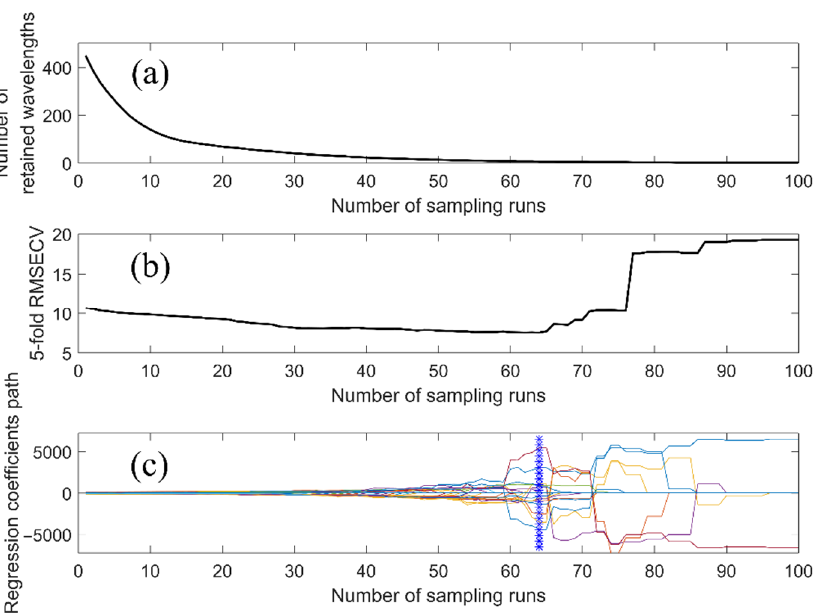
Figure 6. The process of feature wavelength selection by CARS. ( a ) The number of retained wave- lengths with the increase in sampling runs; ( b ) the 5-fold RMESCV of the PLS model established based on the retained wavelengths; ( c ) the regression coefficients of the retained wavelengths in the PLS model.